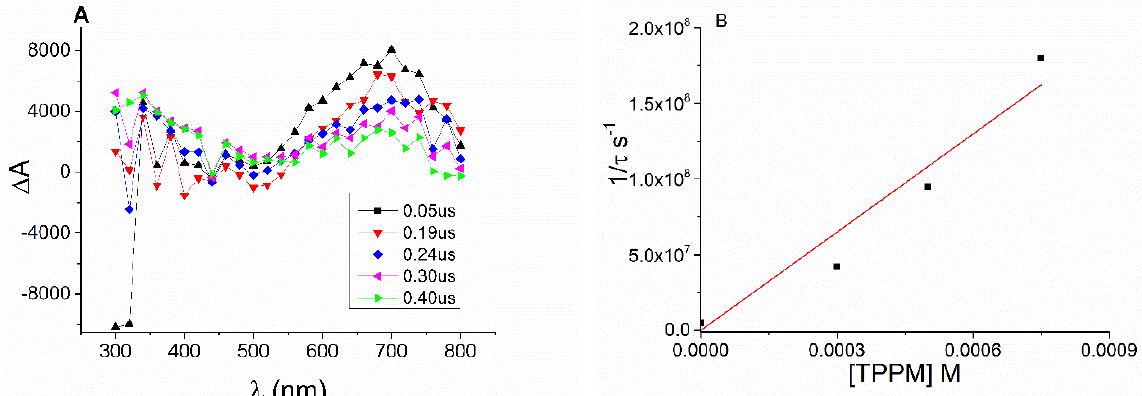
Figure 5. ( A ) Transient absorption spectra of a N 2 -bubbled PBS solution of 3AP at pH 8 at different times after the 355 nm laser pulse. ( B ) Stern – Volmer plot for quenching of the solvated electron by ETPP (from 0 to 0.8 mM) under N 2 .